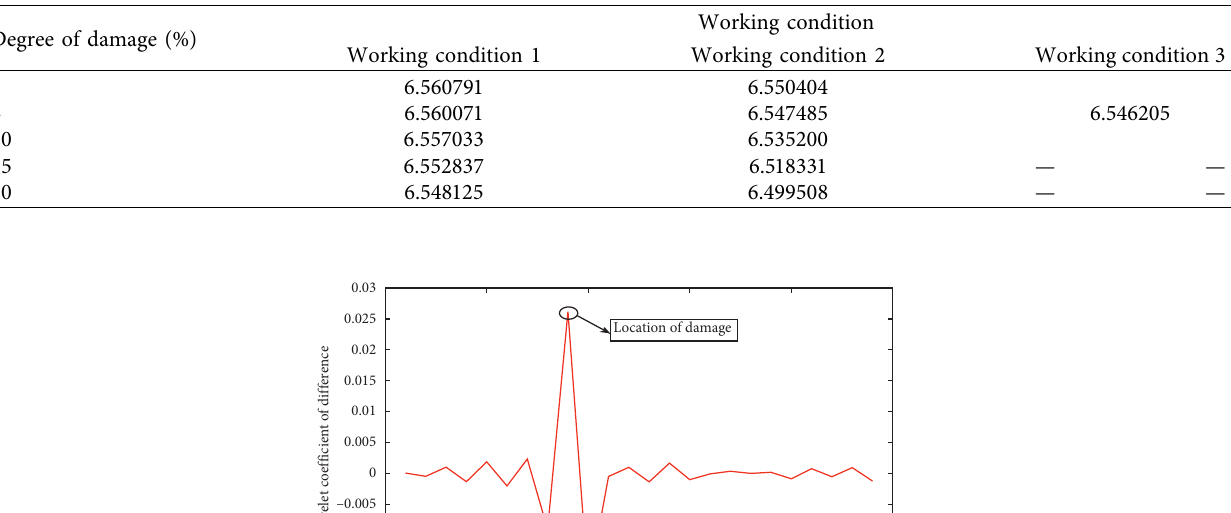
Table 2: Frequency calculation values of each working condition (cycles/s).